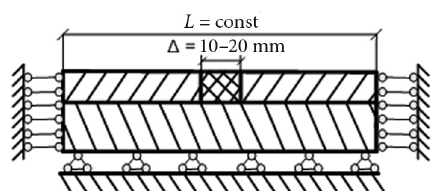
Fig. 11. Design model for the calculation of stresses in asphalt concrete pavement after repairing activities after milling, sealing cracks, applying of a crack-interrupting layer and a wearing layer